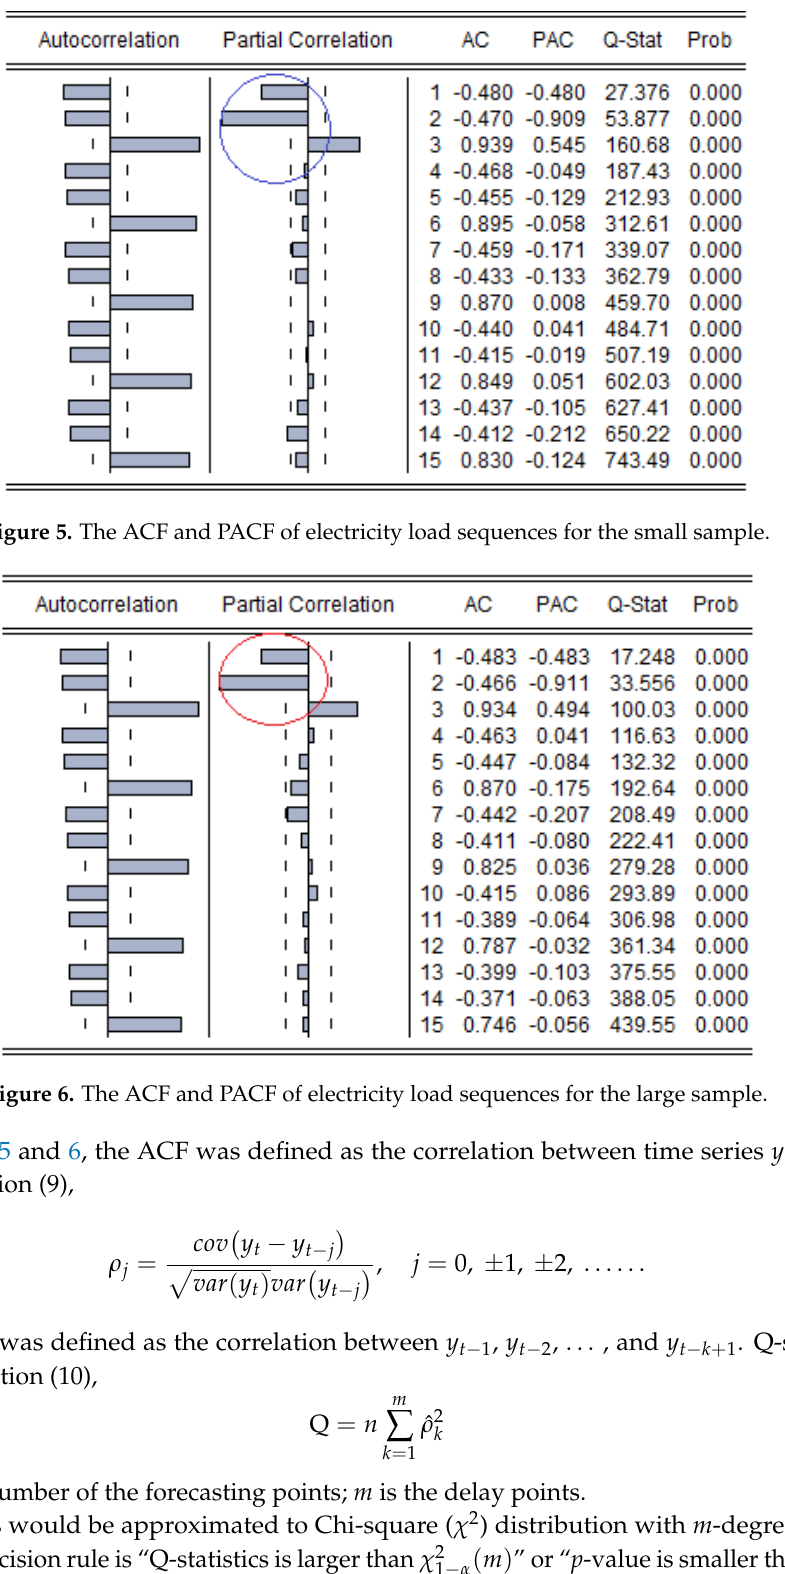
Table 4. Summary of ARMA model recognition graph judgment method.